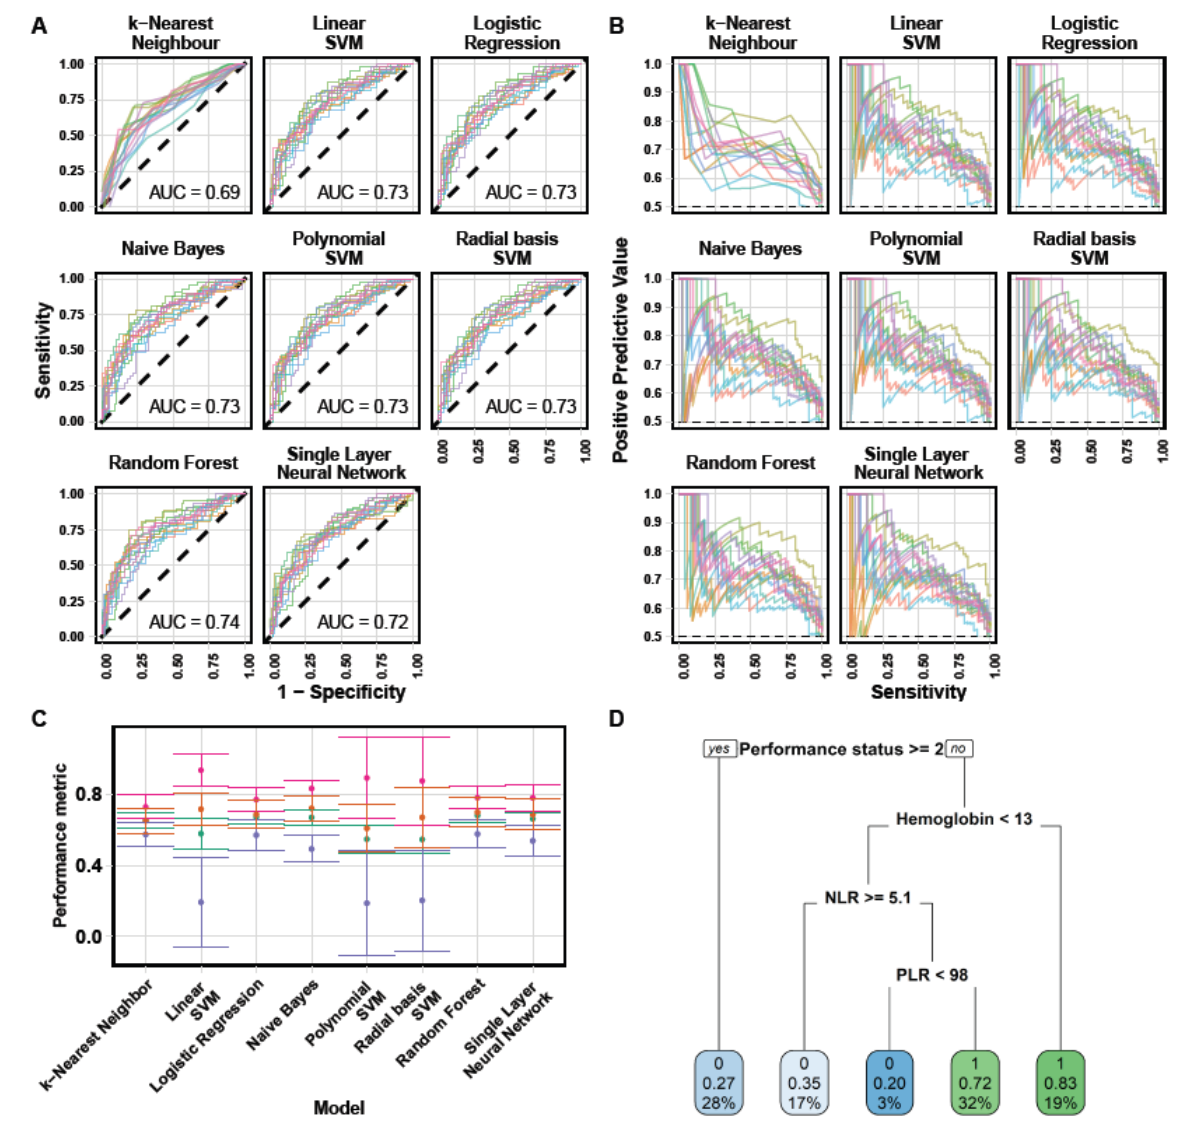
Figure 3. Machine learning algorithms predictive performances. ( A ) Receiver-operator curves for prediction on test sets from each fold of the outer cross-validation loop, for each model. AUC = area under the curve. ( B ) Precision (positive- predictive value)–recall (sensitivity) curves. ( C ) Main performance metrics for each algorithm. ( D ) Decision tree obtained after tuning and training. Each node shows: the predicted class (0 = PD, 1 = CR + PR + SD), the predicted probability of response and the percentage of total observations in the